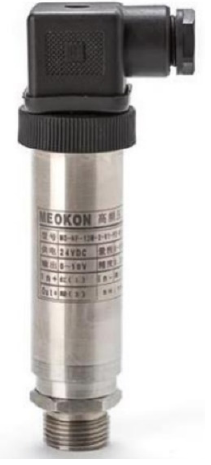
Figure 5. Pressure transducer.